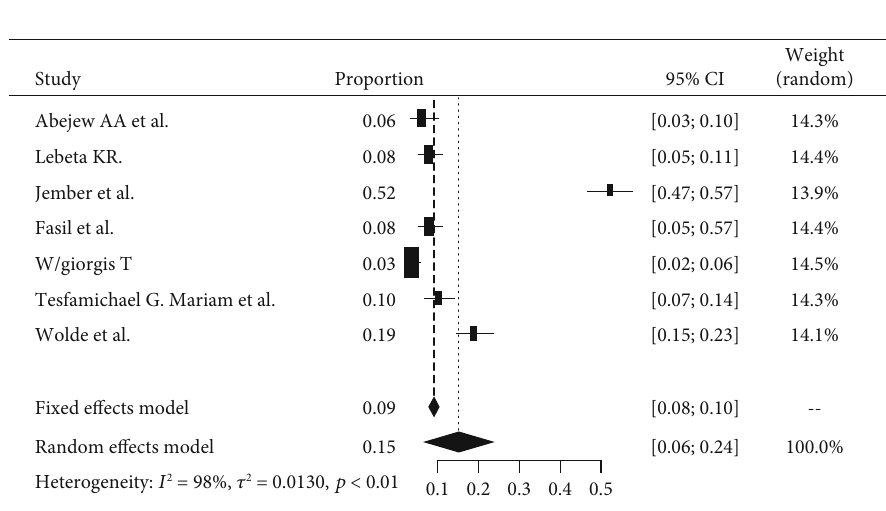
Figure 6: Forest plot of DPN in the south region.